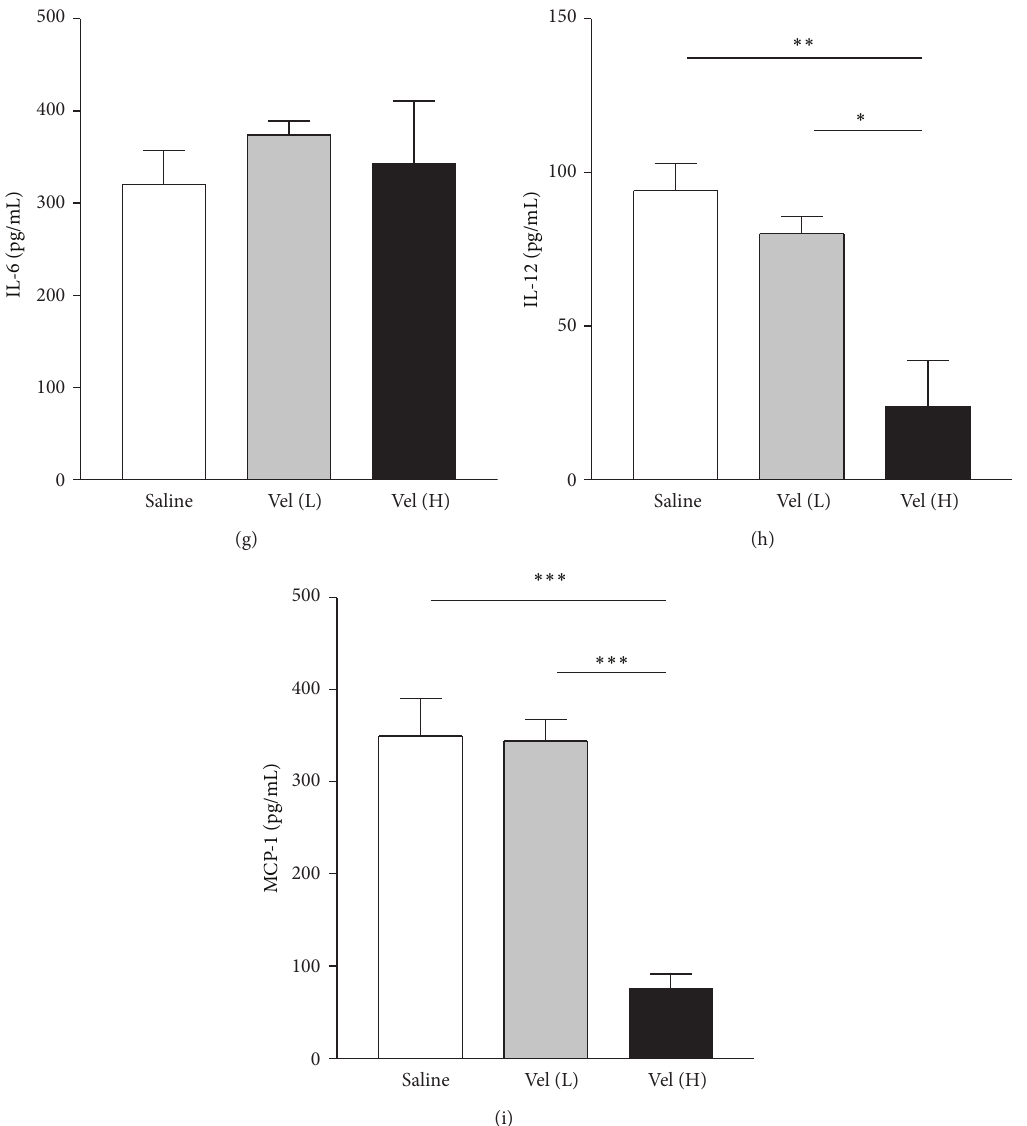
Figure 2: The evaluation of protein expression of inflammatory mediators in retinas of EAU mice in Luminex analysis. Decreased expression of TNF- 𝛼 (a), IL-1 𝛼 (b), IL-1 𝛽 (c), IL-17 (f), IL-12 (h), and MCP-1 (i) relative to the expression in the saline-treated group was noted in the high-dose bortezomib (Vel [H]) group but not in the low-dose bortezomib (Vel [L]) group except for TNF- 𝛼 . In addition, there was no significant difference on the expression of IFN- 𝛾 (d), IL-4 (e), and IL-6 (g) in retinas between bortezomib and saline-treated mice. Data are expressed as the mean SD of three independent experiments (bar graph). ∗ 𝑃 < 0.05 , ∗∗ 𝑃 < 0.01 , and ∗∗∗ 𝑃 < 0.001 , via Student’s 𝑡